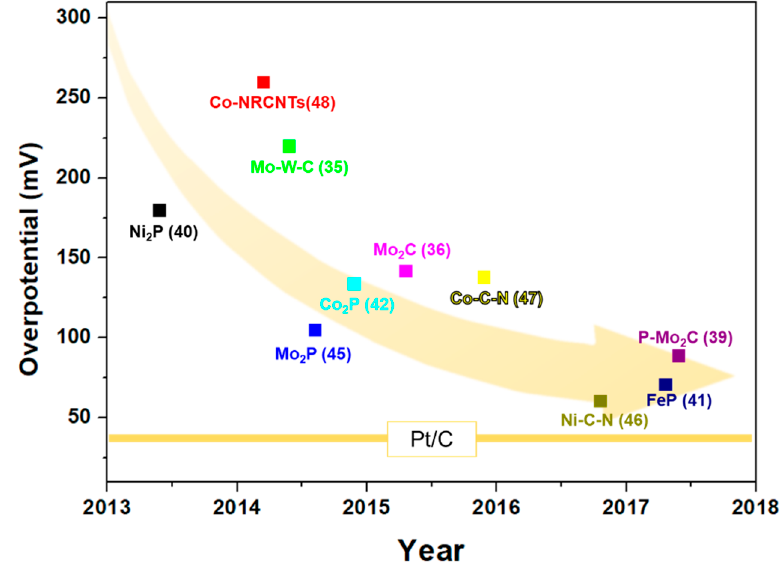
Figure 1. Chronological trend in overpotential at current density of 10 mA cm − 2 of some reported earth-abundant transition metal based catalysts along with the Pt/C catalyst (experimentally measured). Note that all catalysts shown here were measured in 0.5 M H 2 SO 4 to ensure a fair comparison.